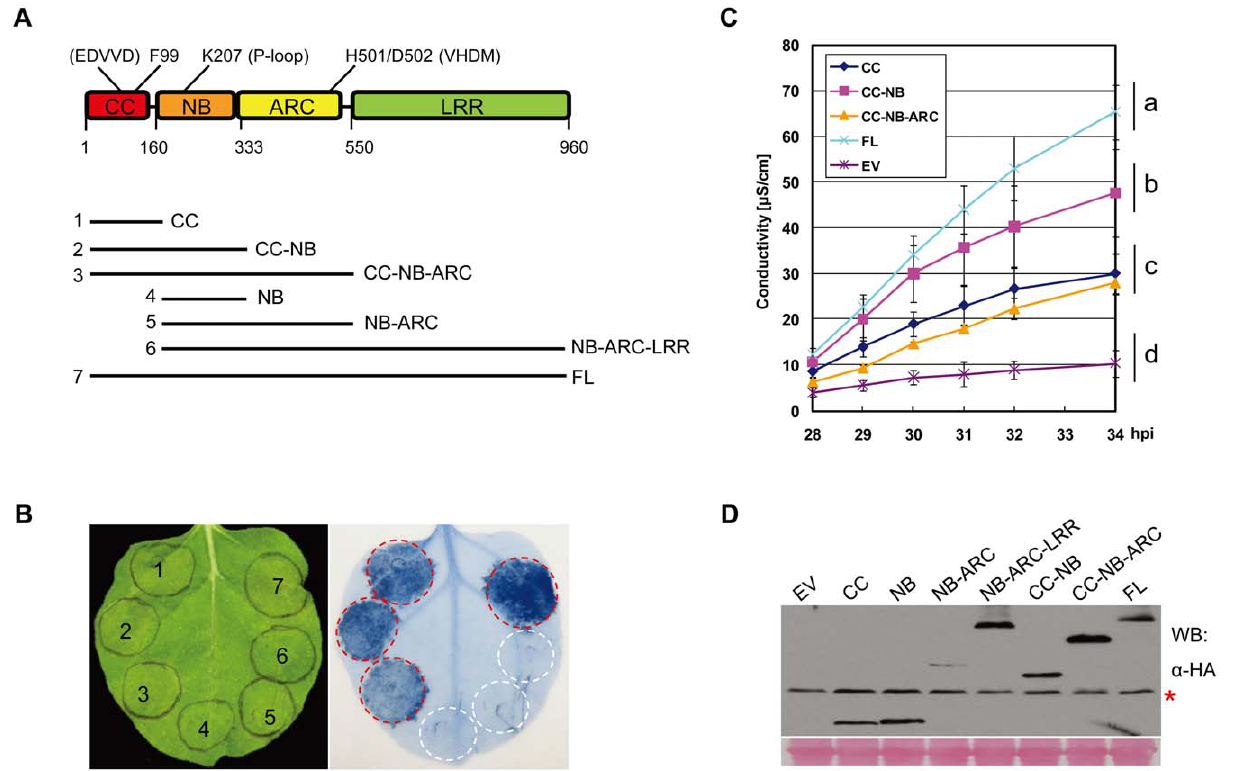
Figure 1. MLA10 CC is the cell death signaling domain whose activity is regulated by other domains. ( A ) Schematic diagram of the MLA10 domain structure and the derived fragments expressed in N. benthamiana . Individual domains of MLA10 are represented by colored boxes, and the relative positions of relevant amino acids and motifs (in parentheses) are indicated on top (upper panel). Lower panel: MLA10 fragments consisting only of the CC domain or the CC combined with other domains are drawn schematically in solid lines. All fragments were expressed as C- terminal -3 6 HA fusions in N. benthamiana leaves using Agrobacterium -mediated transient transformation (Agro-infiltration). ( B ) Analysis of cell death inducing activity of MLA10 fragments. MLA10 fragments or full-length(FL) protein fused with a C-terminal 3 6 HA tag were expressed by Agro- infiltration in N. benthamiana (left), and cell-death triggered by each protein was visualized by trypan blue staining at 42 hrs post Agro-infiltration (hpi) (right). Red circles indicate cell death; white circles indicate no obvious cell death in the infiltrated area. ( C ) Quantification of cell-death inducing activity of MLA10 fragments. Upon expression of the same fragment fusions as indicated in ( B ) by Agro-infiltration in N. benthamiana , electrolyte leakage was measured each hour from 28 to 34 hpi. Error bars were calculated from three replicates per time point and per construct. Experiments were done at least twice with similar results. Letters (a–d) represent groups with significant differences [ p , 0.05, Tukey’s honest significant difference (HSD) test]. ( D ) Protein expression of MLA10 fragments. Total protein was extracted from N. benthamiana leaves at 40 hpi and MLA10-HA was detected by immunoblotting using an anti-HA antibody. Asterisk indicates non-specific signals throughout this article except specified. Ponceau staining of Rubisco small subunit was used to show equal loading throughout this article except specified. EV: empty